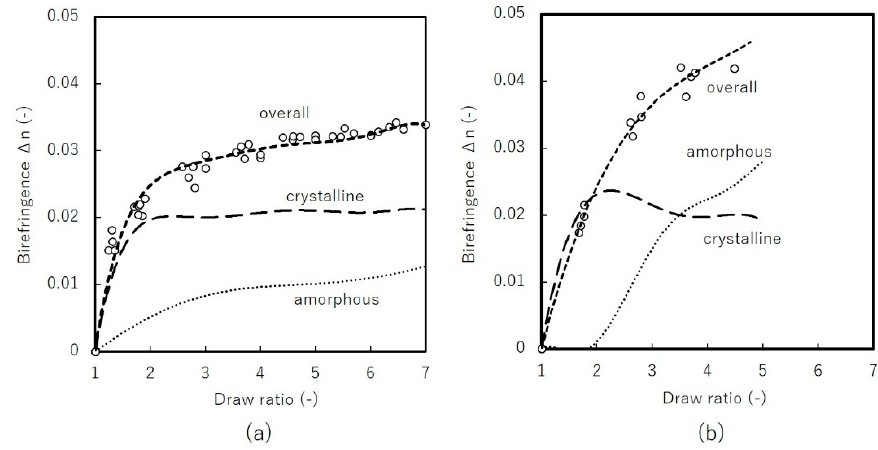
Figure 10. Birefringence vs. draw-ratio of uniaxial: ( a ) free-width ( b ) constrained-width stretched films at 100 °C and 120 °C with stretching speed of 1 m/min.